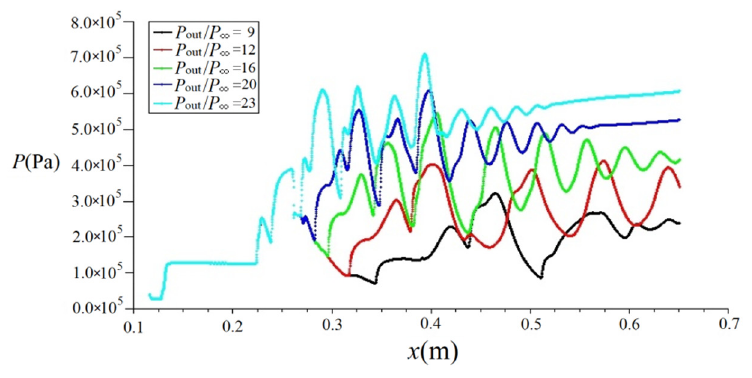
from point F to point E . The lower the back pressure, the lower the average pressure in